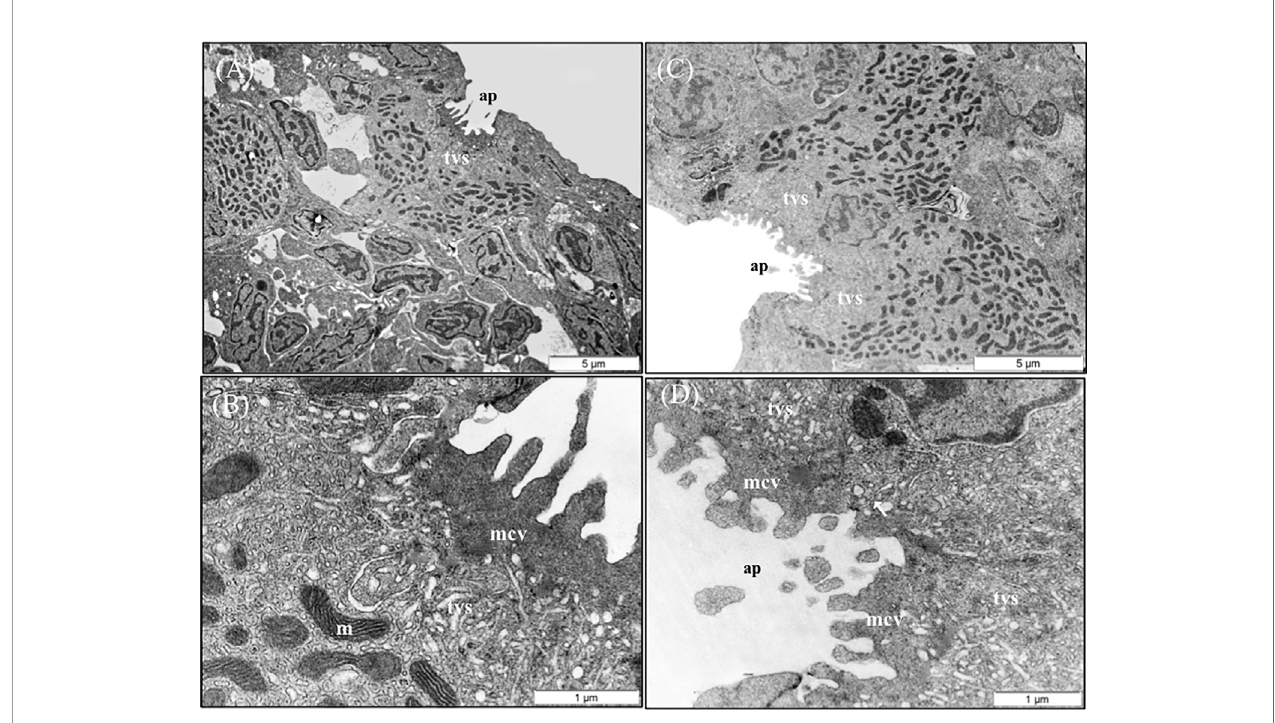
FIGURE 9 | TEM micrographs of mitochondria rich cells (MRCs) present in European sea bass primary lamellae. (A) The crypt of MRC is usually bordered by pavement cells. Scale bar 5 m m. (B) Detail of the apical region of MRC, observe the electron dense microvilli, the tubulovesicular system located just below the microvilli and the mitochondria rich region in the lower region. Scale bar 1 m m. (C) Two MRCs sharing one apical pit. Scale bar 5 m m. (D) Detail of two chloride cells sharing the same apical pit. Juctional unions are indicated by arrows. tvs, Tubulovesicular system; mvc, microvilli; ap, apical pit; m,